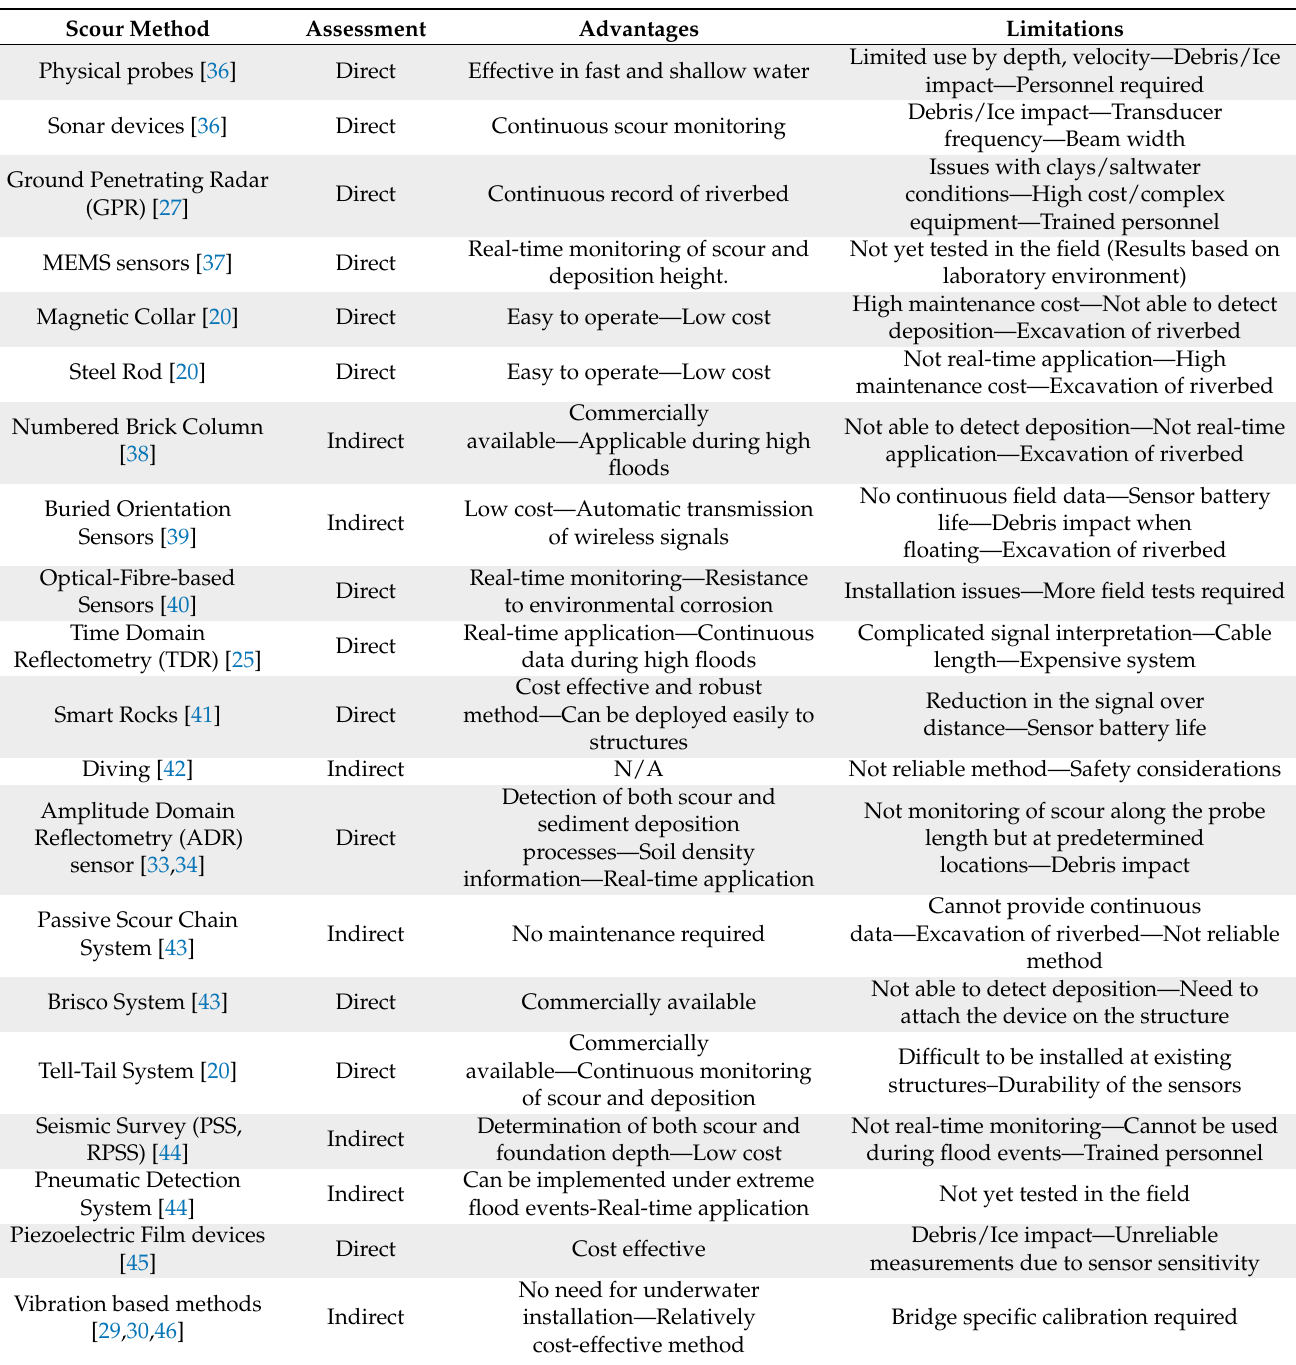
Table 1. Overview of main monitoring methods employed to detect both scour and backfill